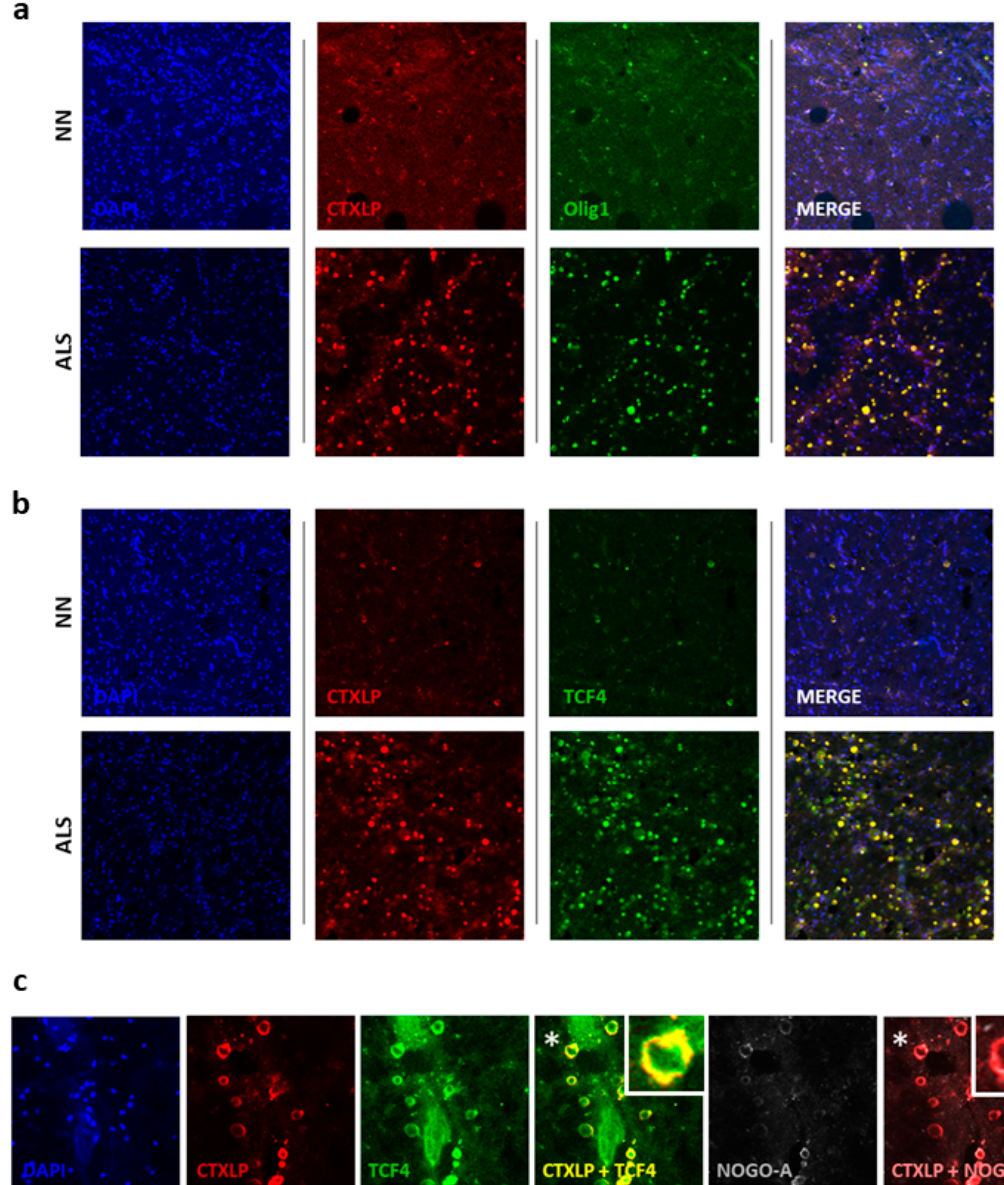
Figure 7. Nogo-A expression in CTXLP + oligodendrocyte precursors may limit spinal cord remyelination in ALS. ERVK CTXLP levels are associated with demyelination, and CTXLP is enhanced in TCF4 + Olig1 + oligodendrocyte precursors in cervical spinal cord tissues from patients with ALS. ( a , b ) ERVK CTXLP expression in ex vivo cervical (CC) spinal cord of NN controls ( n = 5) and patients with ALS ( n = 5) analyzed by confocal imaging (representative 20 × confocal micrographs are shown). In ALS tissue, CTXLP expression (red) co-localizes with Olig1 (green, panel A) or TCF4 (green, panel B) markers indicative of oligodendrocyte precursor cells. DAPI stain depicts cellular nuclei. ( c ) ERVK CTXLP + oligodendrocyte precursors either express myelin inhibitory protein Nogo-A or lie in close proximity to Nogo-A positive cells (Figure S9b) in spinal cord tissues of patients with ALS. Human ex vivo cervical spinal cord tissues were stained for ERVK CTXLP (red), TCF4 (green), Nogo-A (grey), and nuclei (blue) in NN controls ( n = 5) and patients with ALS ( n = 5). Image merging for CTXLP and TCF4 indicates that oligodendrocyte precursors express CTXLP in ALS. White stars indicate areas that are magnified to depict overlapping protein expression in CTXLP + rings. Neurite outgrowth inhibitor (Nogo-A) is a key regulator of OPC differentiation; when OPCs express Nogo-A they are unable to progress towards a mature OL phenotype capable of myelination